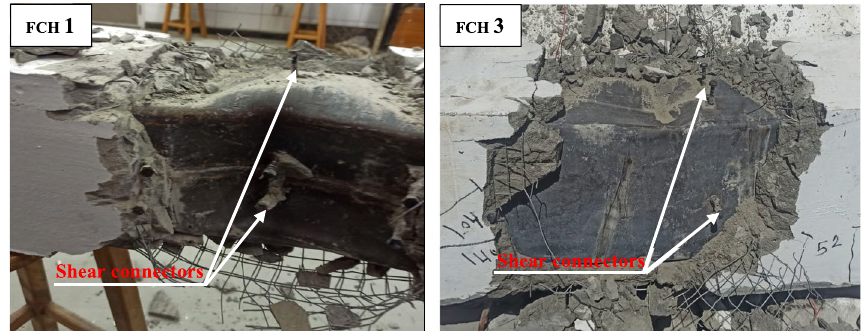
Fig. 17 FCH1 and FCH3 shear connecters after test